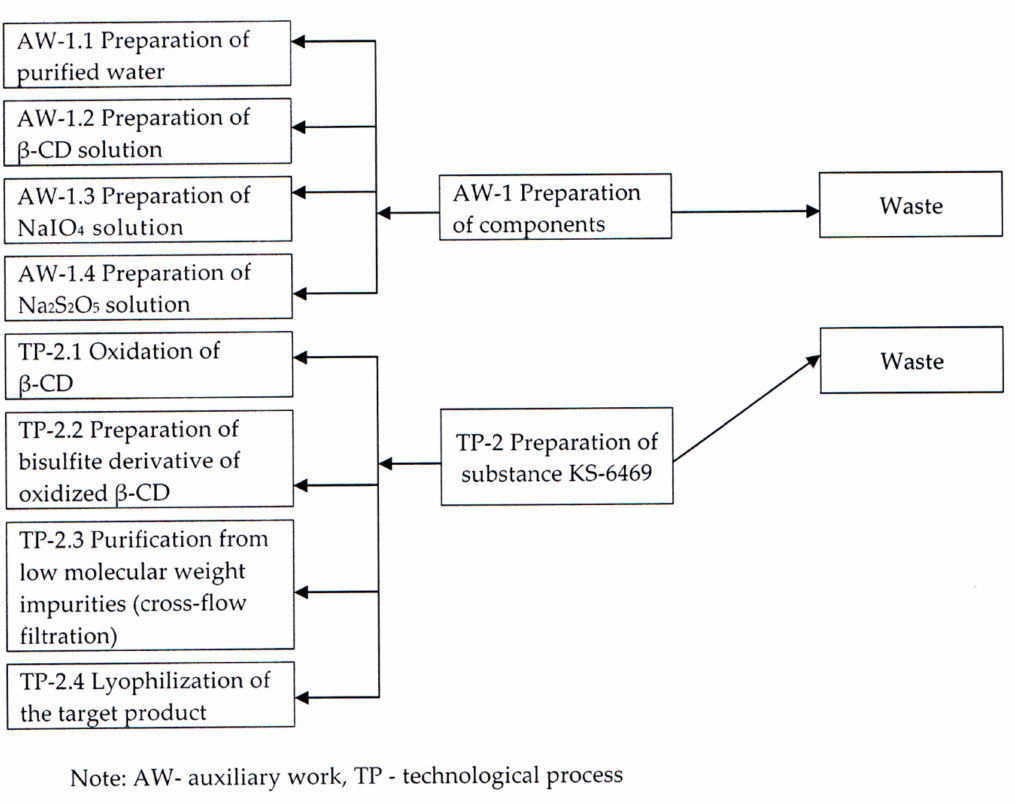
Figure 8. Optimized technological scheme of obtaining the substance KS-6469.